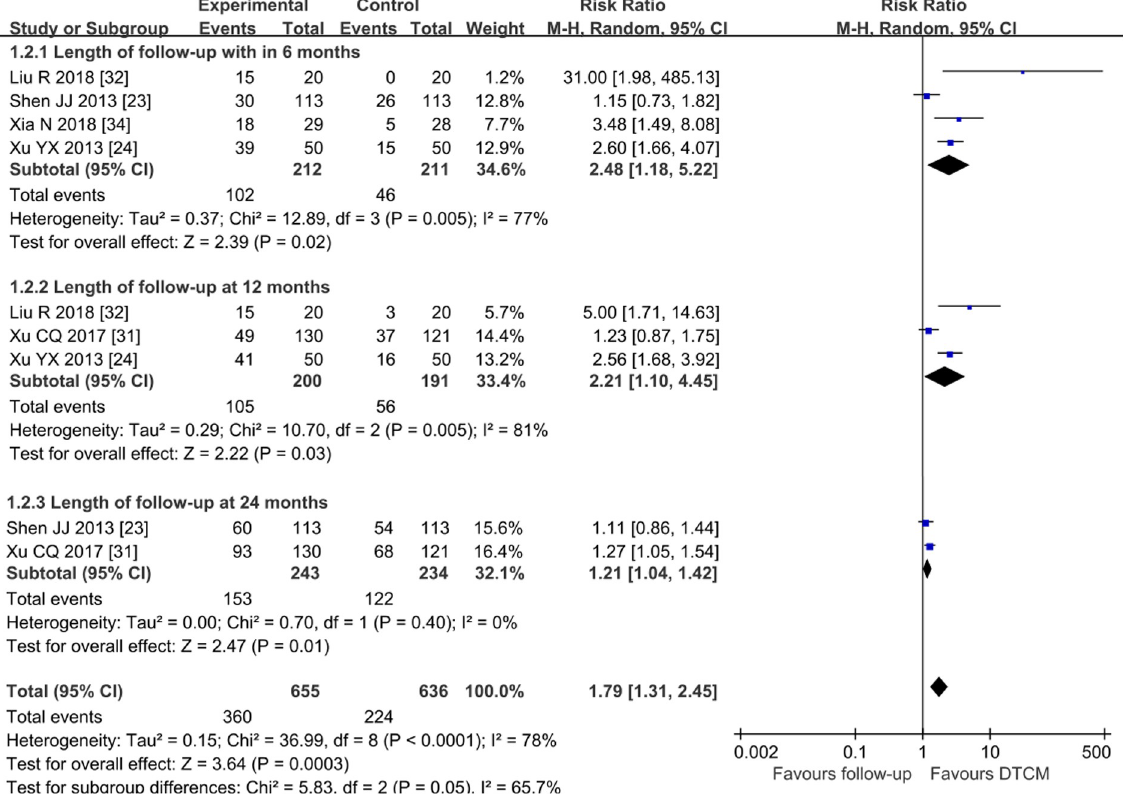
Fig 3. Analysis 1.2 Forest plot of comparison: DTCM treatment alone compared with follow-up. Outcome 1.2: Regression rate of CIN.